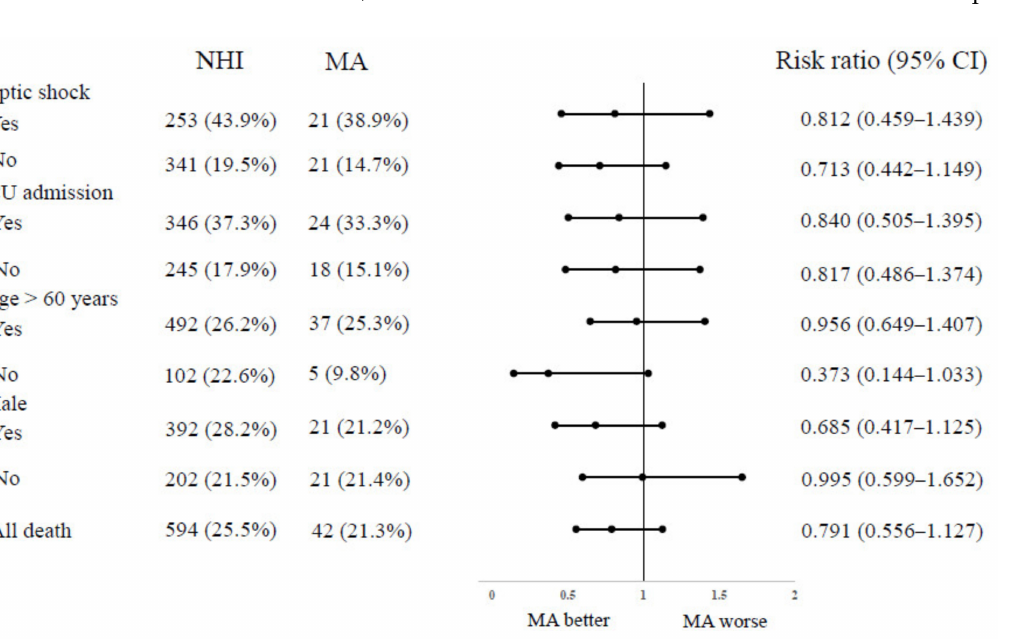
Figure 3. In-hospital mortality by subgroups. We performed subgroup analysis to examine the impact of the patients’ health insurance status on in-hospital mortality by septic shock, ICU admission, age, and sex. In-hospital mortality was not different in all subgroups. NHI, National Health Insurance; MA, Medical Aid.; CI, confidence interval. Table 3. Patient characteristics stratified as per the primary